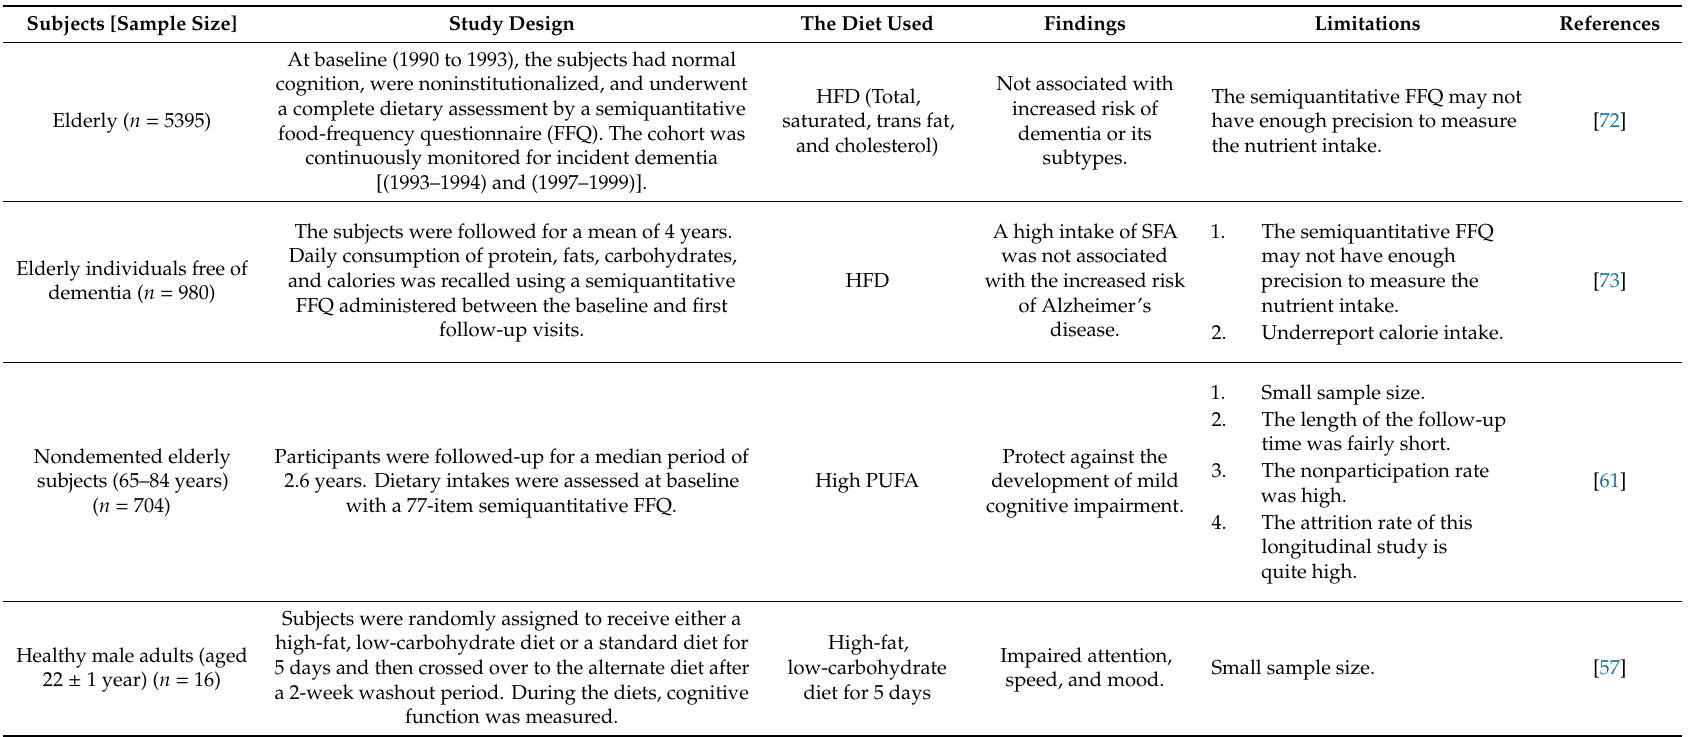
Table 2. The e ff ects of a HFD on cognitive function in human